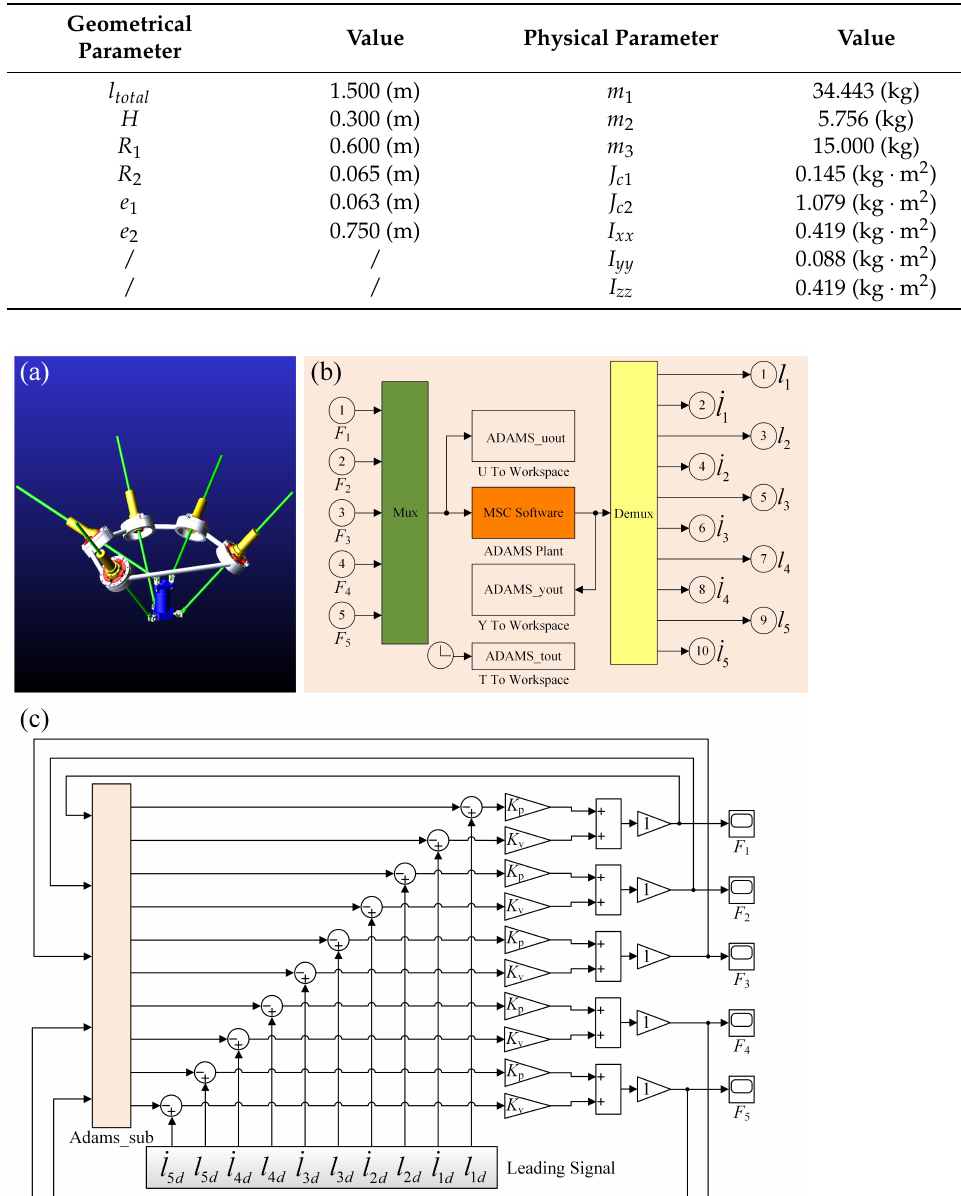
Table 1. The geometrical parameters and the physical parameters of the mechanism.